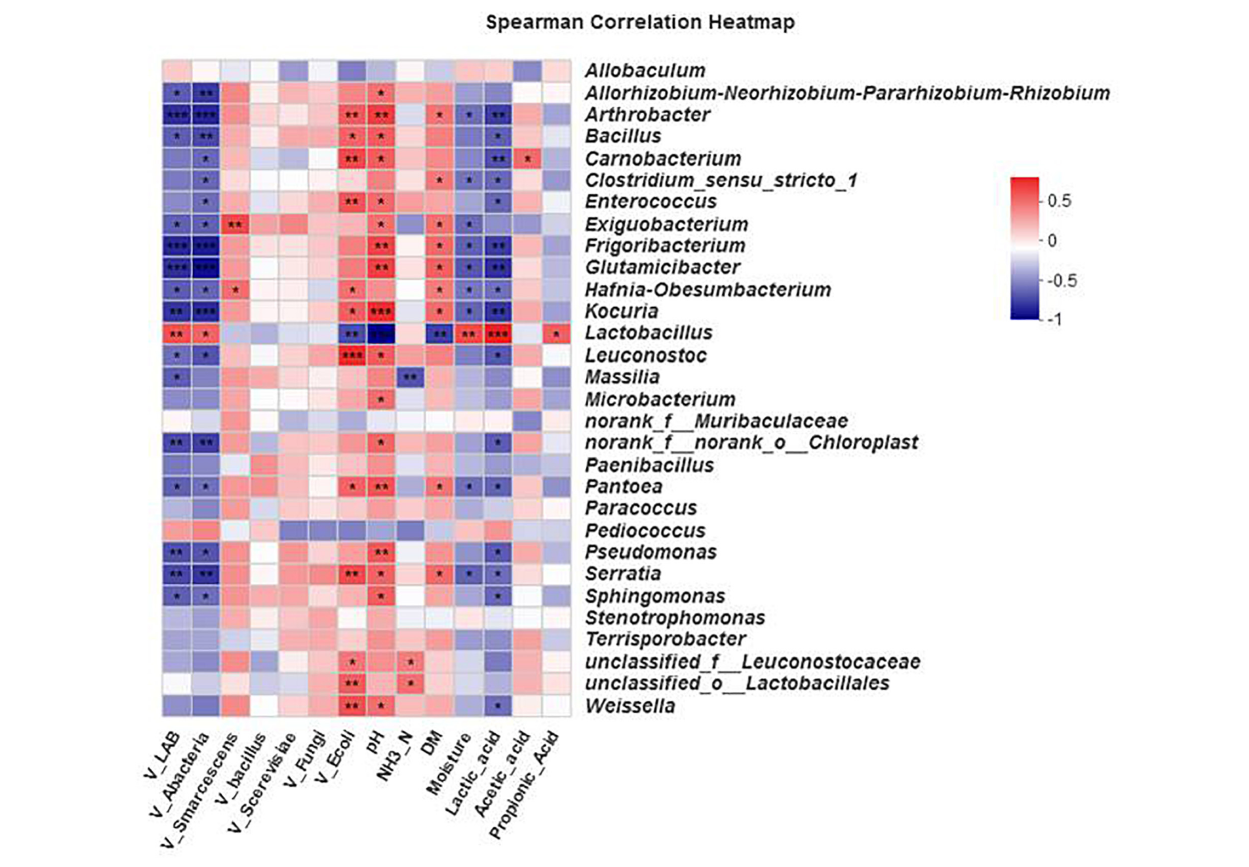
FIGURE 5 | Spearman’s correlation heat map for bacteria at the genus level. ∗ 0.01 < P ≤ 0.05, ∗∗ 0.001 < P ≤ 0.01, ∗∗∗ P ≤ 0.001. Microbial classification and environmental variables. The x -axis and y -axis are environmental factors and species, respectively. Different R values are shown in different